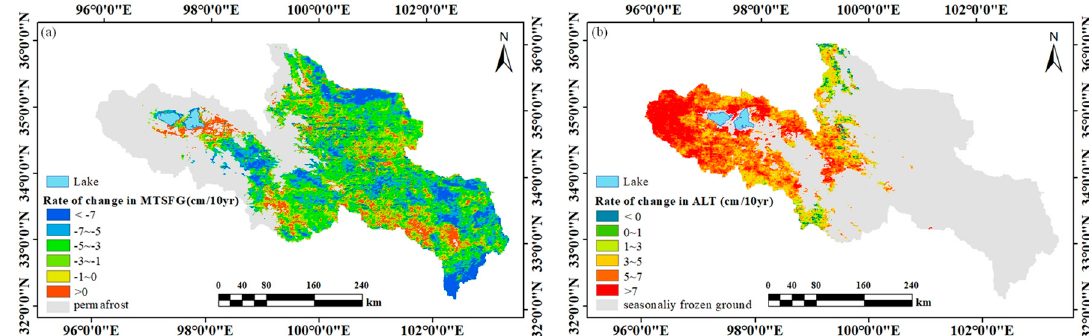
Figure 7. Spatial distribution of the change rate of the ( a ) annual maximum thickness of the seasonally-frozen ground (MTSFG) and ( b ) the annual active layer thickness (ALT) of the permafrost in the period from 2003 to 2019.